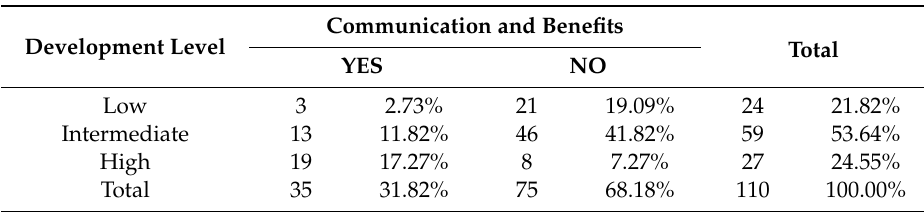
Table 2. Contingency table of absolute and relative (as % of the total) frequencies of PMM system development level and consistent communication and benefits.